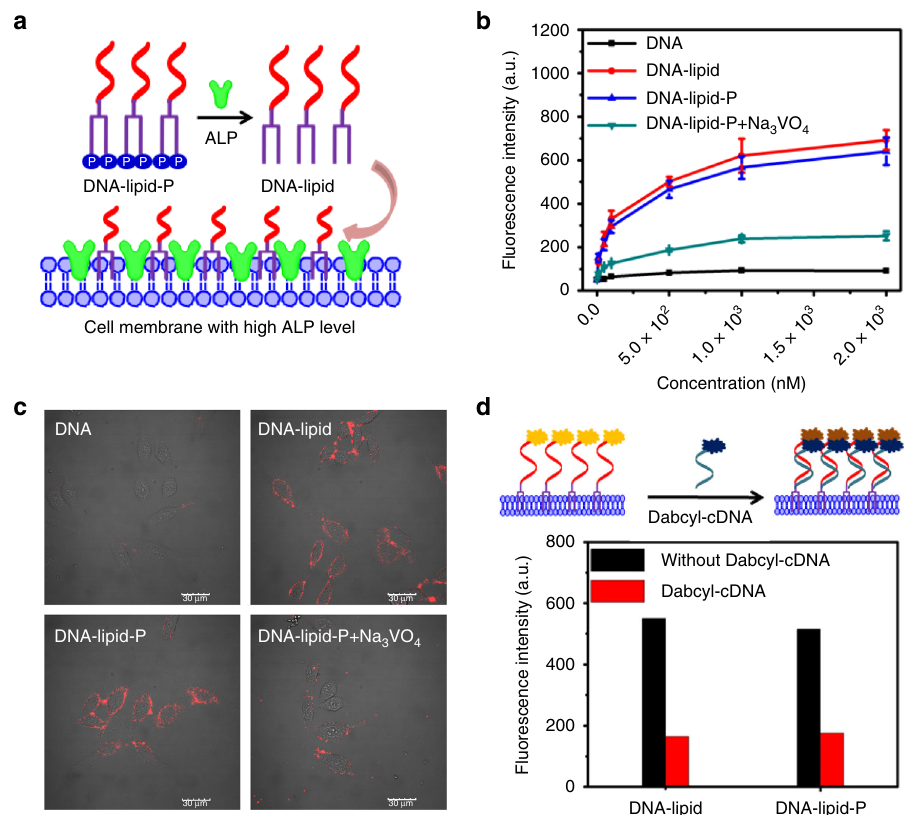
Fig. 5 ALP-dependent cell membrane anchorage of DNA-lipid-P. a Schematic illustration of ALP-dependent cell membrane anchorage of DNA-lipid-P. b Mean fl uorescence intensity of HepG2 cells treated with TAMRA-labeled DNA, DNA-lipid, DNA-lipid-P or DNA-lipid-P + Na 3 VO 4 (2 mM) for one hour at 37 °C. Error bars indicate standard deviation. c Confocal fl uorescence microscopy imaging of HepG2 cells treated with 1 μ M TAMRA-labeled DNA, DNA-lipid, DNA-lipid-P or DNA-lipid-P + Na 3 VO 4 (2 mM) for one hour at 37 °C. Scale bar is 30 μ m. d Hybridization-induced fl uorescence quenching of membrane-anchored TAMRA-labeled DNA-lipid or DNA-lipid-P with